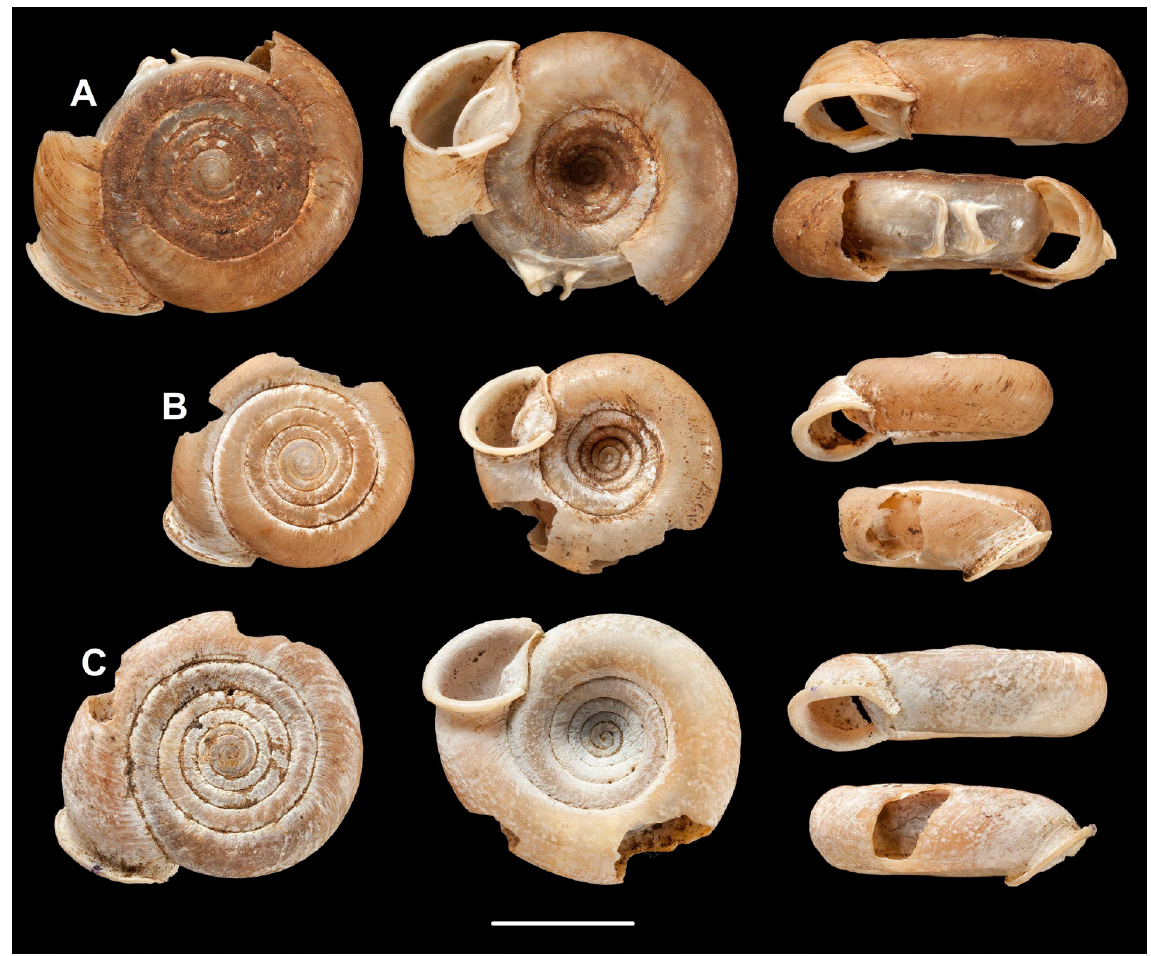
Fig. 20. Shells of species of Chersaecia Gude, 1899. A . C. magna (Gude, 1897) comb. nov., holotype